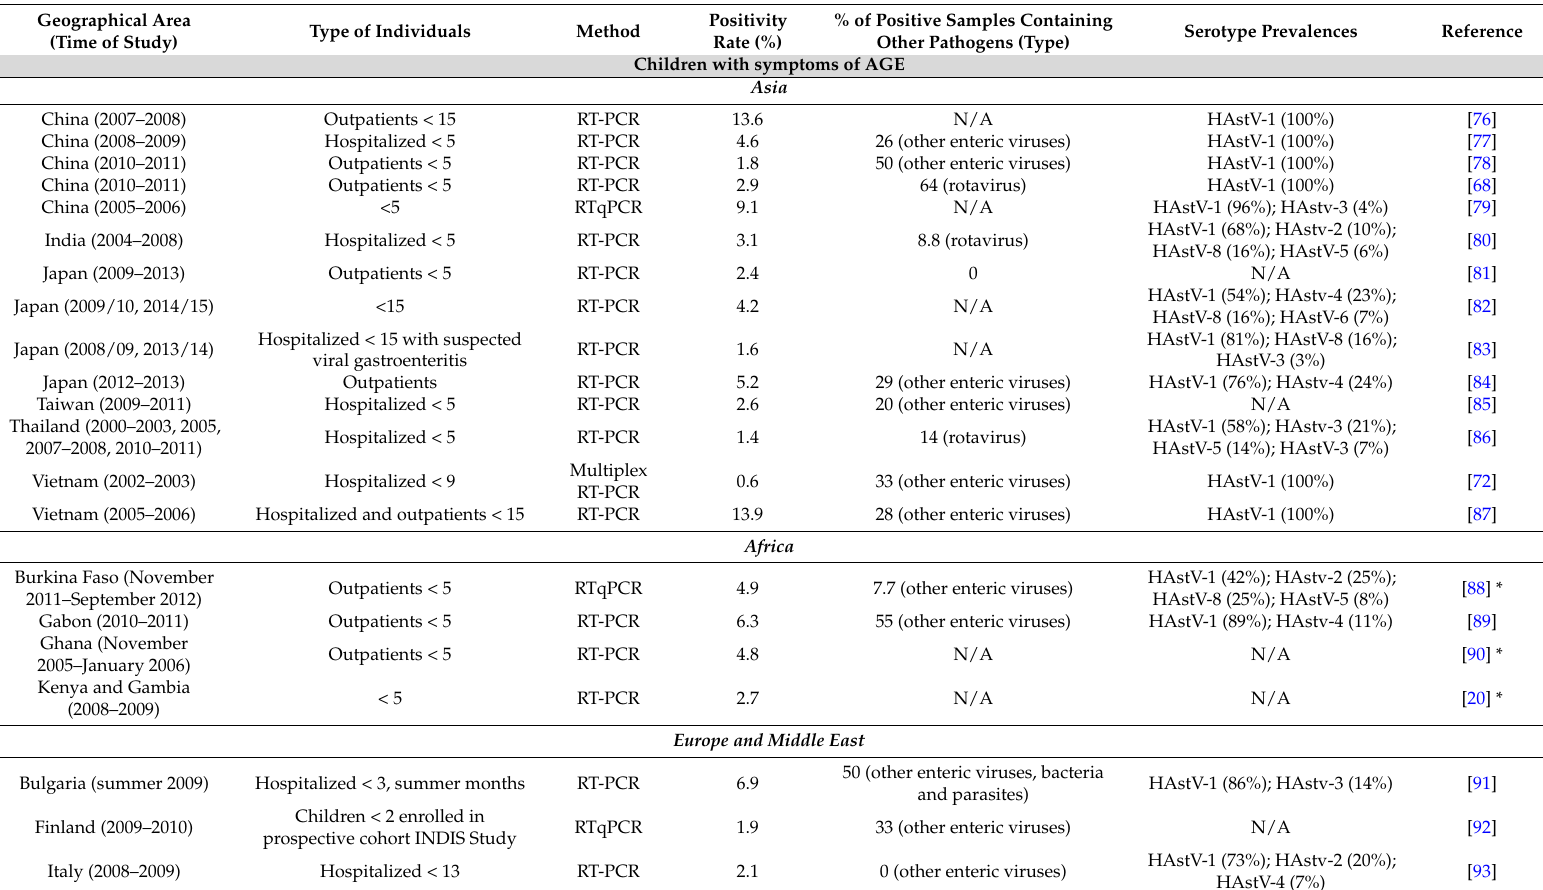
Table 3. Major epidemiological studies to determine the classic HAstV positivity rate among different populations, published over the last 10 years. Geographical Area (Time of